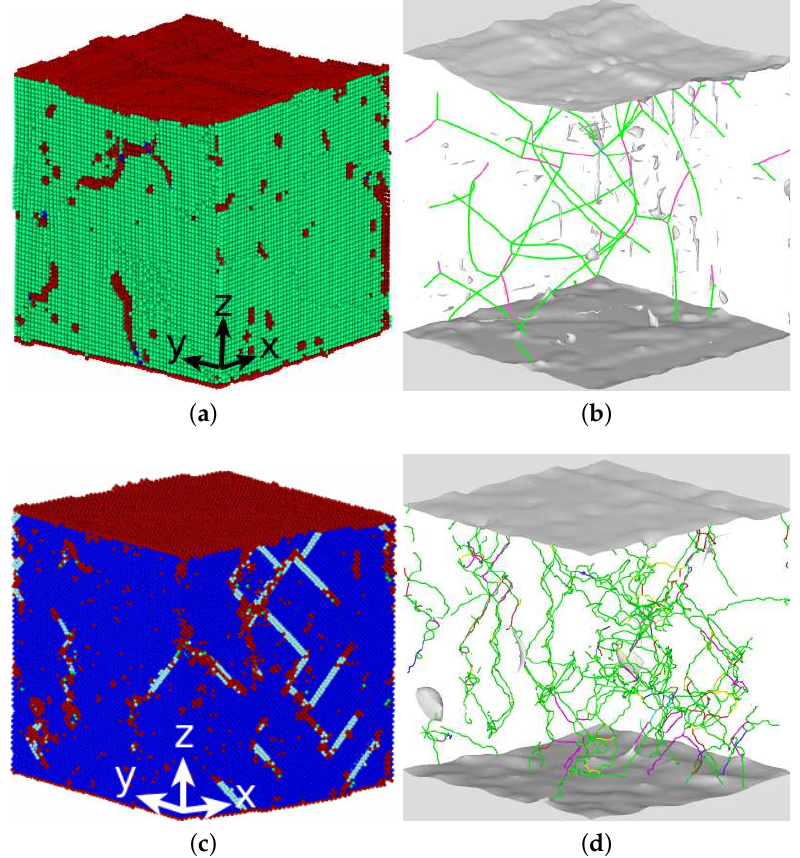
Figure 1. Examples of dislocation-filled samples used in the simulation. ( Top row ) bcc sample used for studying the austenitic transformation: ρ = 4.5 × 10 12 cm − 2 . ( a ) The local lattice structure: bcc (green), fcc (dark blue), hcp (light blue), and unidentified (red); ( b ) the dislocation network: 1/2 (cid:104) 111 (cid:105) (green) and (cid:104) 100 (cid:105) (pink). ( Bottom row ) fcc sample used for studying the martensitic transformation: ρ = 13.6 × 10 12 cm − 2 . ( c ) The local lattice structure as in ( a ); ( d ) the dislocation network: 1/6 (cid:104) 112 (cid:105) (green), 1/6 (cid:104) 110 (cid:105) (pink), 1/2 (cid:104) 110 (cid:105) (blue), 1/3 (cid:104) 100 (cid:105) (yellow), and other